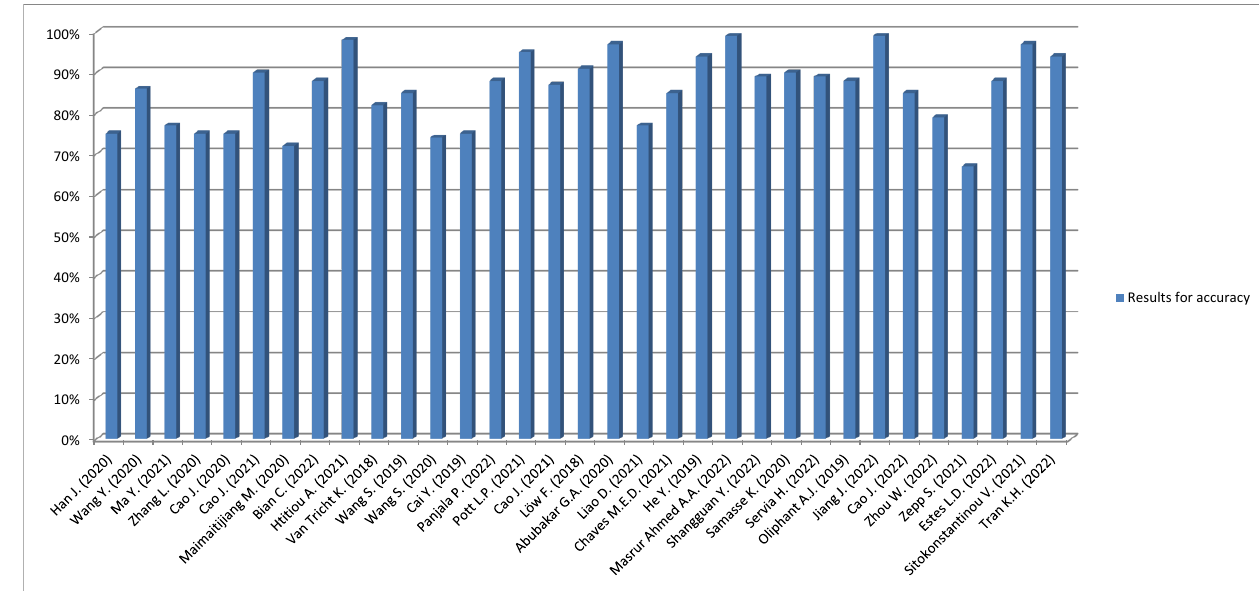
Figure 6. Results for accuracy found by the different studies.